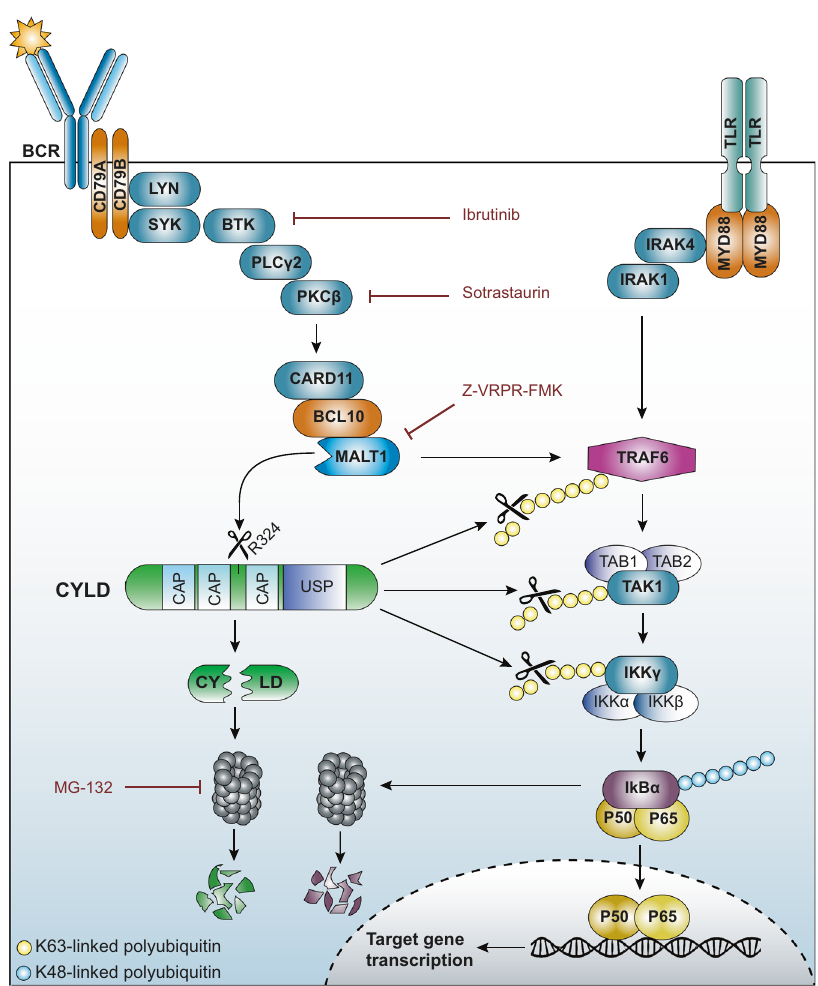
Fig. 7 Model of the role of CYLD in NF- κ B activation in B-cell lymphomas. Upon B-cell receptor (BCR) ligation, tyrosine residues within the ITAM motifs of CD79 are phosphorylated by the Src-family tyrosine kinase LYN leading to activation of spleen tyrosine kinase (SYK). Subsequently, Bruton ’ s tyrosine kinase (BTK) is activated and can then phosphorylate phospholipase C γ 2 (PLC γ 2). PLC γ 2 mediates the formation of second messengers that activate protein kinase C β (PKC β ). PKC β phosphorylates caspase recruitment domain-containing protein 11 (CARD11) provoking a conformational change and allowing CARD11 to interact with B-cell lymphoma 10 (BCL10), and subsequently MALT1. MALT1 is a protease that cleaves various target proteins, including CYLD. In addition, oligomerized MALT1 functions as a scaffolding protein allowing recruitment of the E3 ubiquitin ligase tumor necrosis factor receptor-associated factor 6 (TRAF6). In parallel, Toll-like receptor (TLR) engagement results in MyD88-dependent recruitment of IL-1 receptor-associated kinase-4 (IRAK4) and subsequently IRAK1. IRAK4 phosphorylates IRAK1, which then can associate with TRAF6. BCR/TLR-activated TRAF6 promotes Lys-63-linked ubiquitination of TRAF6 itself as well as transforming growth factor beta-activated kinase 1 (TAK1) and NEMO/IKK- γ . Ubiquitinated TRAF6 binds to adaptor proteins TAB1/2/ 3, leading to the recruitment and auto-phosphorylation of TAK1. Ubiquitination of NEMO/IKK- γ mediates the recruitment of the IKK subunits to the TAK1/TAB complex, thereby facilitating the phosphorylation of IKK- β by TAK1. IKK- β then phosphorylates I κ B α resulting in Lys-48- polyubiquitination and subsequent proteasomal degradation which allows NF- κ B dimers to translocate to the nucleus. The deubiquinating enzyme CYLD consists of three conserved cytoskeleton-associated protein glycine-rich (CAP-Gly) domains and a C-terminal catalytic ubiquitin- speci fi c protease (USP) domain that is able to hydrolyze lysine 63-linked ubiquitin chains. CYLD can hydrolyze Lys-63-linked polyubiquitin chains of TRAF6, TAK1 and/or NEMO/IKK- γ , thereby suppressing NF- κ B activation. Accordingly, MALT1-dependent cleavage of CYLD substantially reduces its functionality and initiates its proteasomal degradation, thereby promoting cell growth and NF- κ B